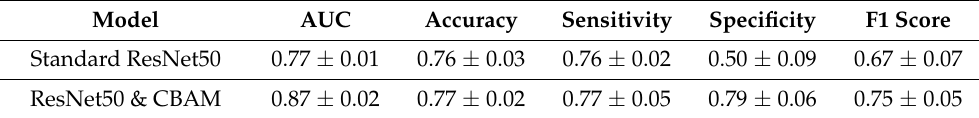
Table 2. Performance comparison between two ResNet50 models with and without using CBAM.